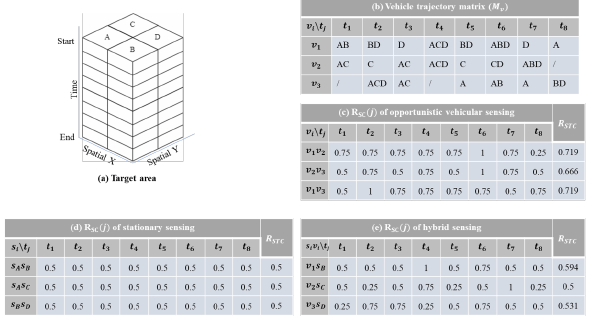
Figure 1. Spatial and spatiotemporal coverage ratios of stationary, opportunistic vehicular and hybrid sensing, with two sensors, G s = 2 × 2 ( { A, B, C, D } ), G t = T / 8 , and candidate vehicles V = { v 1 , v 2 , v 3 }